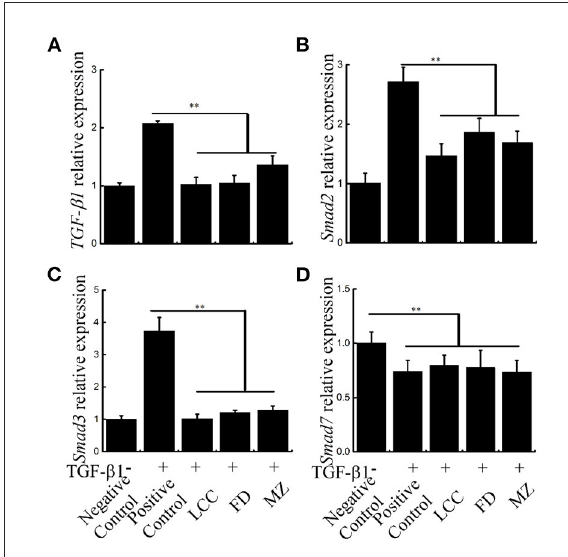
FIGURE7 The effects of TEVs on the TGF- β 1/Smads signal pathway in LX-2 cells. (A) mRNA expression of TGF- β 1 was analyzed by Real-time PCR. (B) mRNA expression of Smad2 was analyzed by Real-time PCR. (C) mRNA expression of Smad3 was analyzed by Real-time PCR. (D) mRNA expression of Smad7 was analyzed by Real-time PCR. Error bar represents SD ( n = 3; * P < 0.05, ** P < 0.01, indicating significantly different from control group).